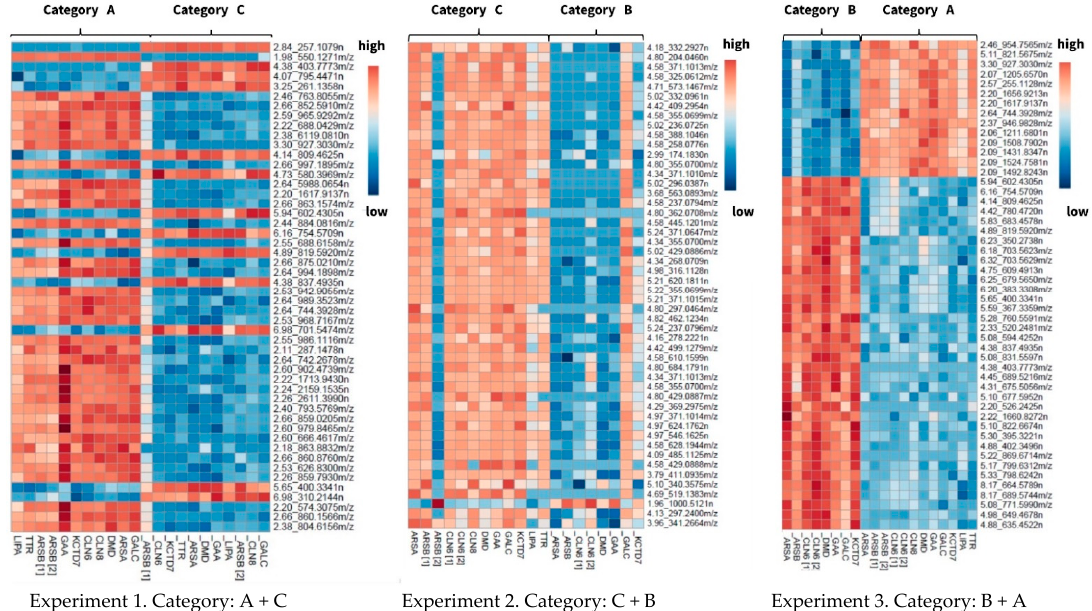
Figure 4. The heatmaps show differences in the abundance of identified compounds across various types of samples. Only the 50 most significant compounds were selected. The colors indicate the abundance of the metabolites: brown indicating the higher level and blue the lower level. The darker the square, the more significant the difference. The data were log-transformed and auto-scaled. The individual samples (columns) and compounds (rows) are separated using hierarchical clustering (Ward’s algorithm).